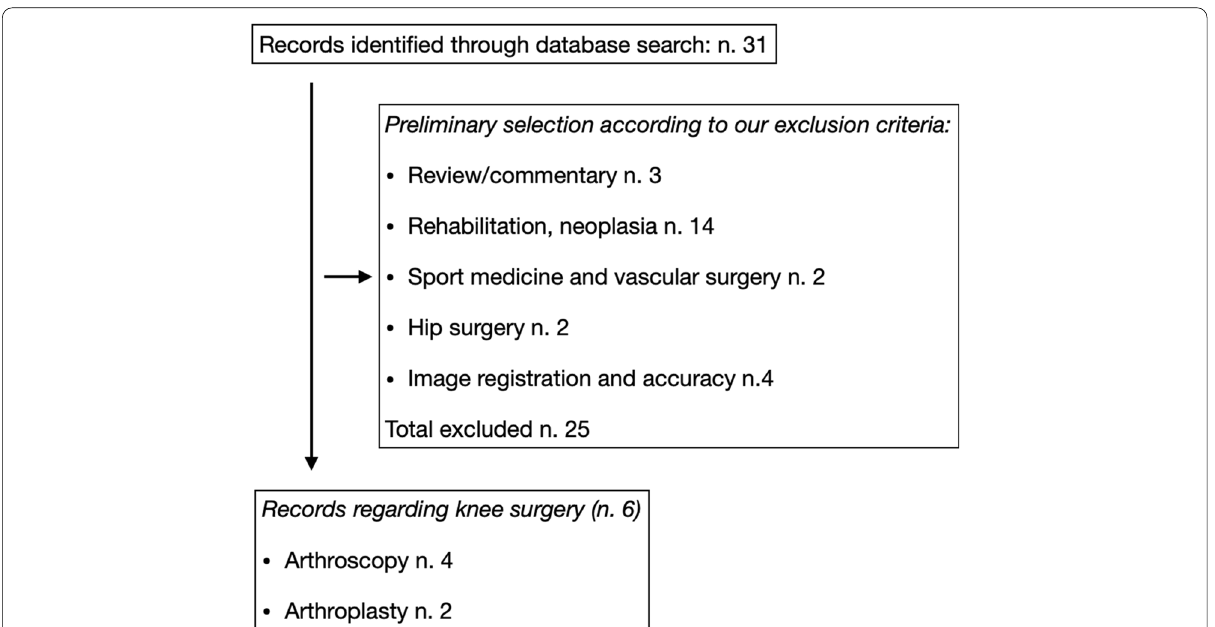
Fig. 1 Selection protocol: abstract selection chart according to our inclusion criteria. Abstract inclusion and exclusion criteria are highlighted in the